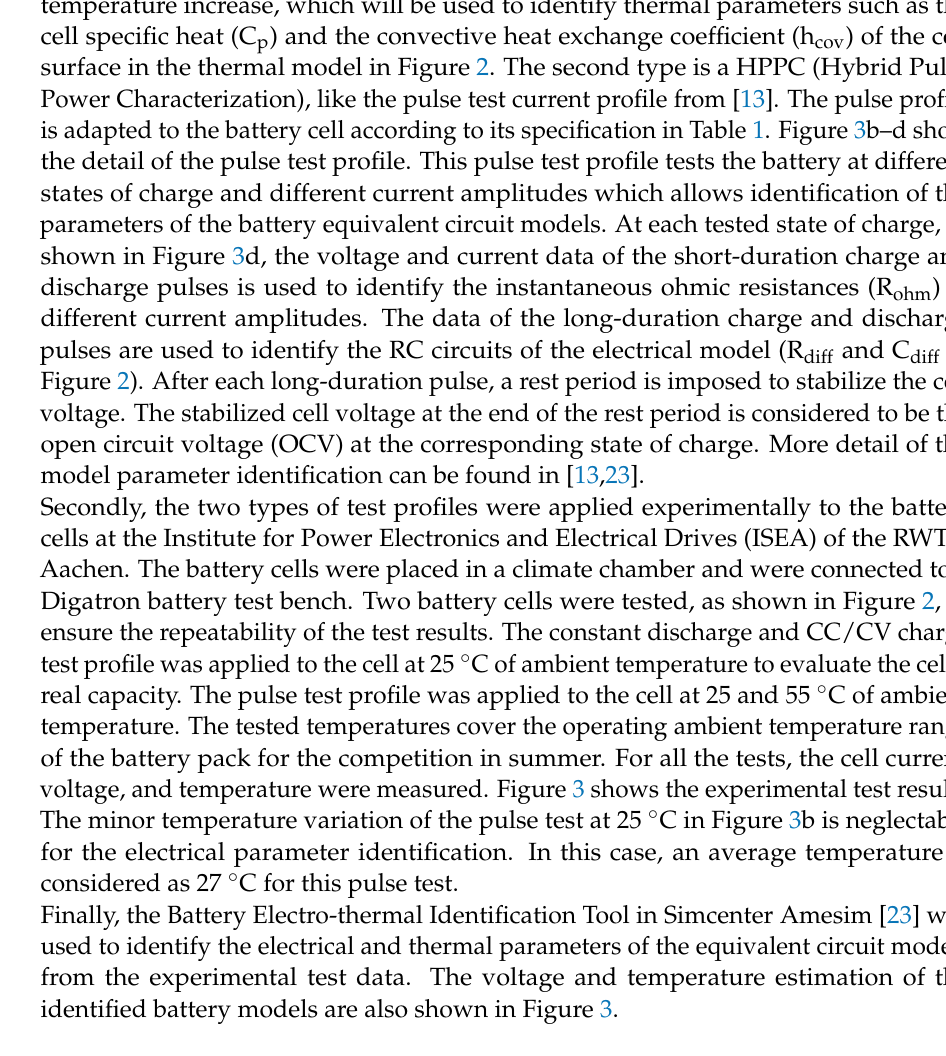
Figure 3. Experimental test data and model estimations from the Battery Electro-thermal Identifica- tion Tool in Simcenter Amesim: ( a ) constant discharge and standard CC/CV charge test; ( b ) pulse test at 25 °C; ( c ) pulse test at 55 °C; ( d ) zoom of pulse test at 55 °C. To validate the cell electrical and thermal models, a validation profile was applied to the cell via the test bench at different ambient temperatures. The validation profile in- cludes a fast charge phase from about 0% State of Charge (SoC) and several dynamic driv- ing cycles at different SoCs, as shown in Figures 4b,c. A battery cell simulation sketch in Simcenter Amesim, as in Figure 4a, is used to compare the model voltage and temperature